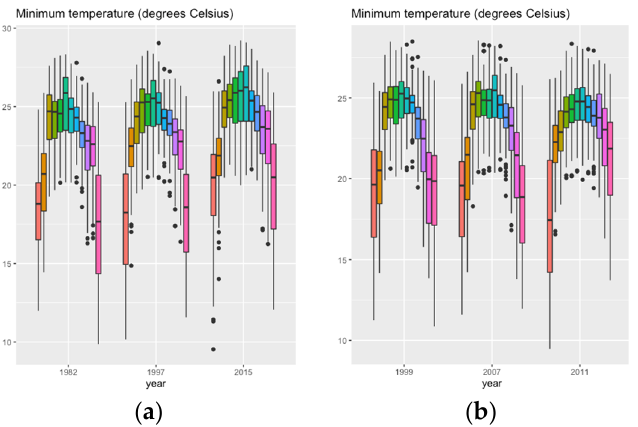
Figure 4. Boxplots of climate factors of 124 Thai meteorological stations by ENSO, years and months: ( a ) El Niño; ( b ) La Niña.